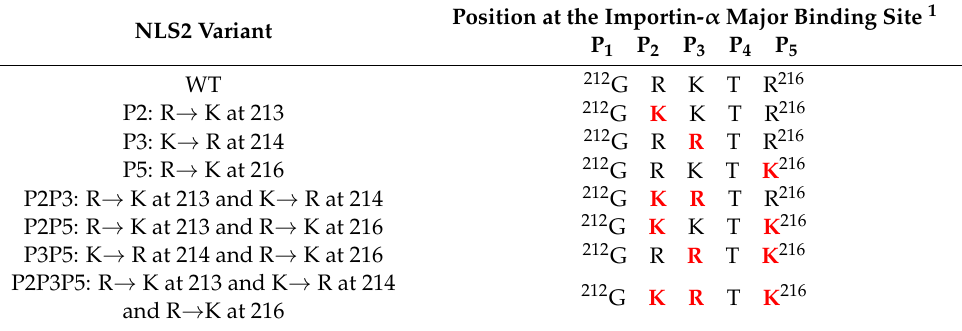
Table 2. Name of NLS2